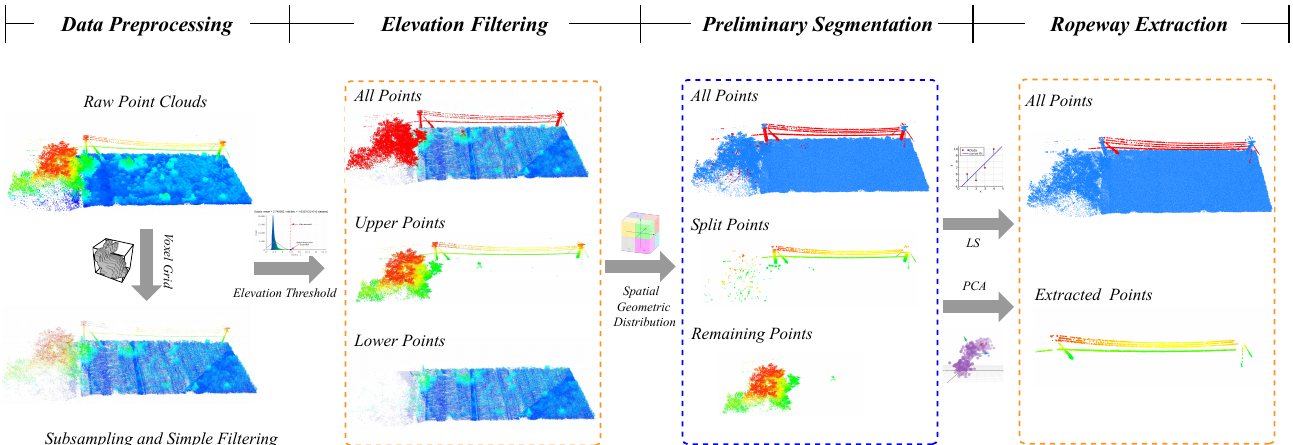
Figure 2. Diagram of the system’s working principle. In addition, there are different colors in the gradient bar ( ) in the point cloud data set that represent different